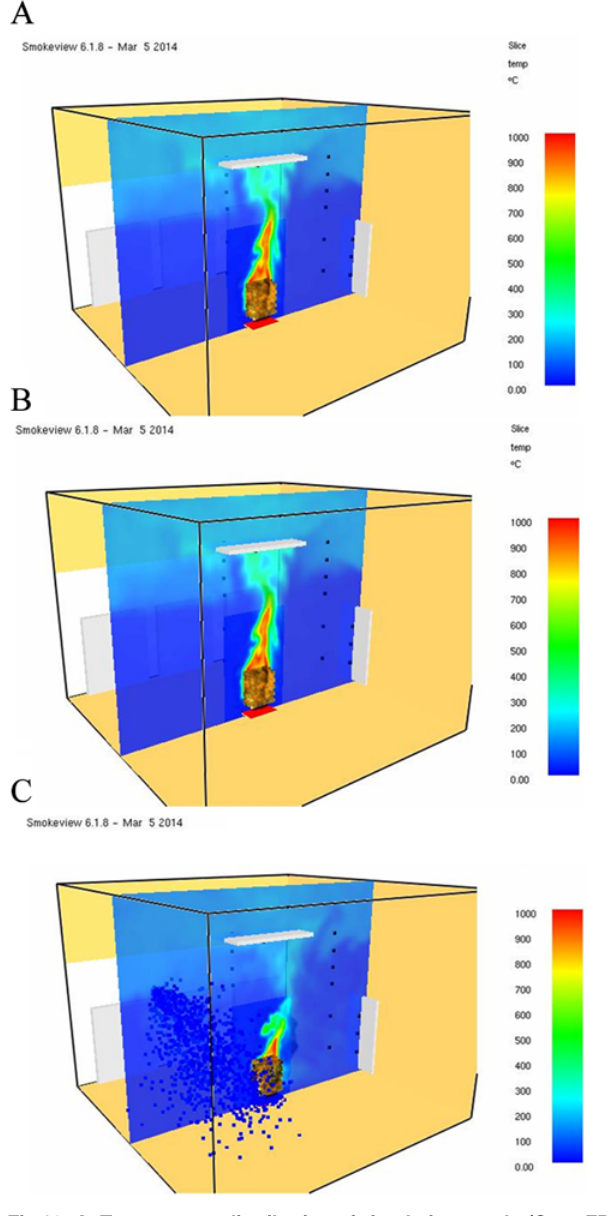
Fig 13. A: Temperature distribution of simulation results(Case FDS 6@180 s). B: Temperature distribution of simulation results(Case FDS 6 spk-n @180 s). C: Temperature distribution of simulation results(Case FDS 6 spk @180